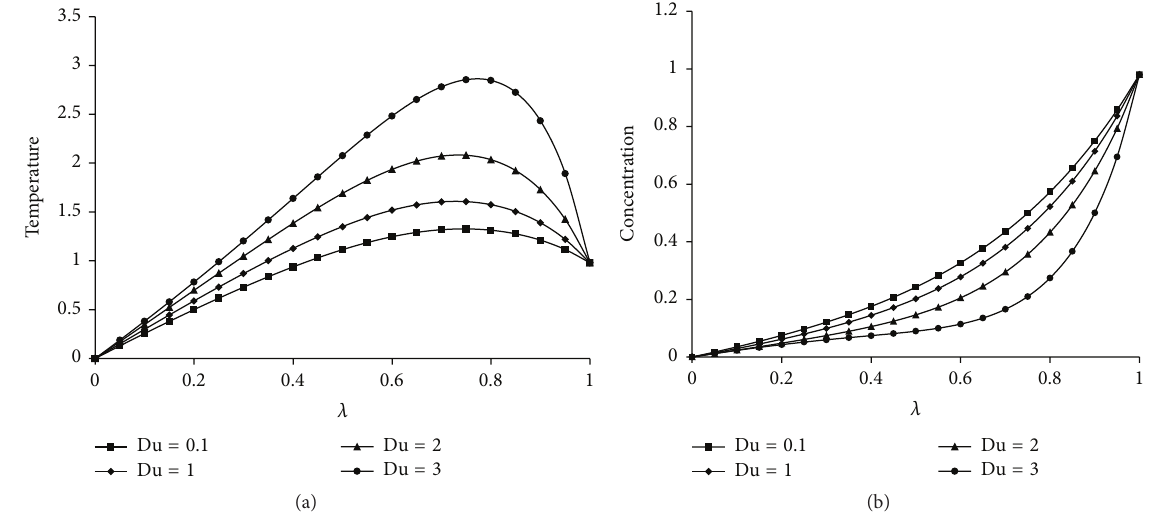
Figure 3: Effect of Du on (a) temperature and (b) concentration for Kr = 2, Gr = 4, Gm = 4, Re = 2, Sr = 1, Sc = 0.22, Pr = 1, 𝑎 = 0.2 , 𝜓 = 0.2 , = 0.2 , 𝑠 = 2 , 𝑠 = 10 , Ha = 1, 𝐷 −1 = 2 , and Ec = 𝑅 = 0.2 , 𝐽 1 1 2